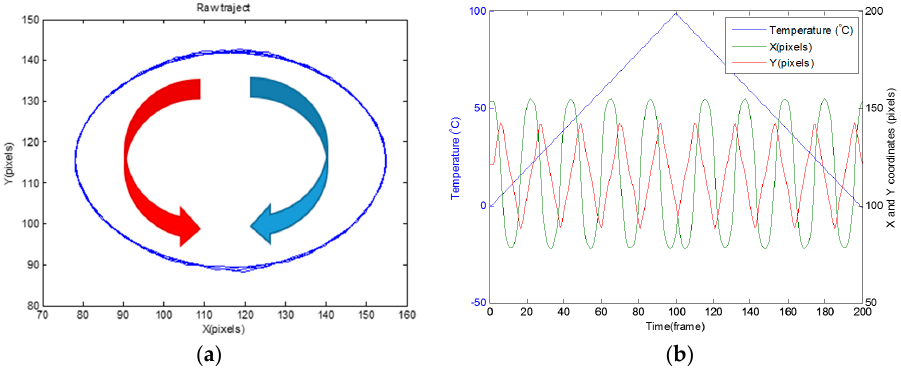
Figure 6. Center of mass calculation: elliptical rotating pattern in the counterclockwise direction for heating and in the clockwise direction for cooling ( a ), and coordinates along the X and Y axes of the center of mass ( b ).